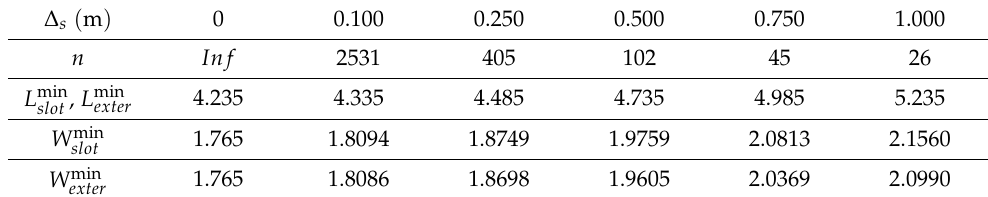
Table 2. Minimum parking space under different ∆ s